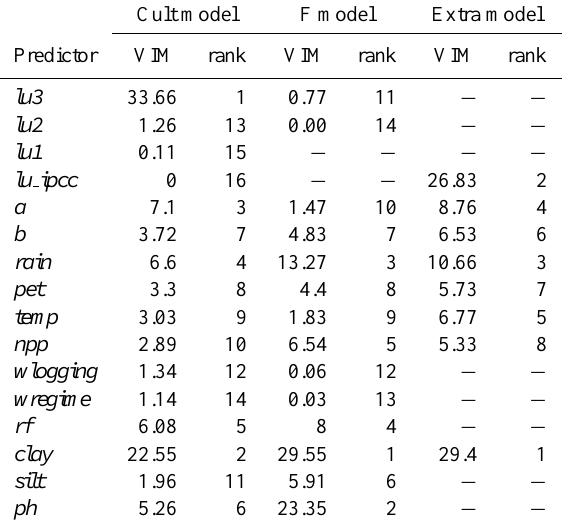
Table 3. Relative influences of the predictors for each model, ex- pressed as variable importance indexes (VIM), and rank according to the VIM values. The predictors are grouped, starting with the variables related to land use, then related to the climatic or pedo- climatic factors, then to plant productivity and finally related to the soil properties only. Variables names and definitions are detailed in Sects. 2.1.1 and 2.3.1.